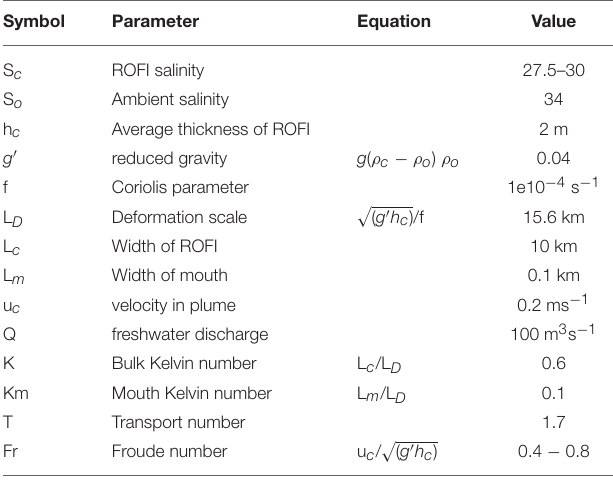
TABLE 1 | Key ROFI parameters at the WilsonB mooring, 26 km seaward of the Waihou river. Symbol